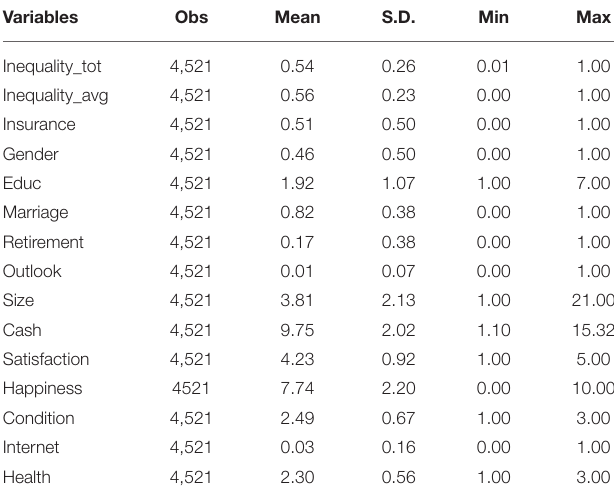
TABLE 1 | The definitions of all